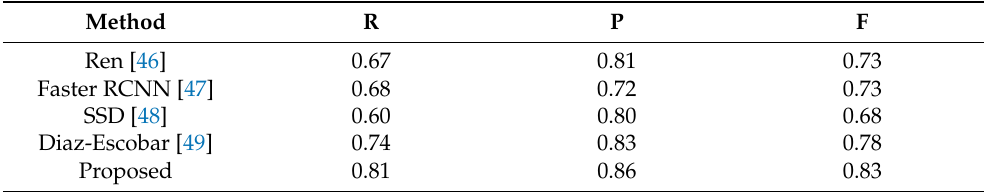
Table 5. Comparison of text detection results of various methods on the ICDAR 2013 dataset.